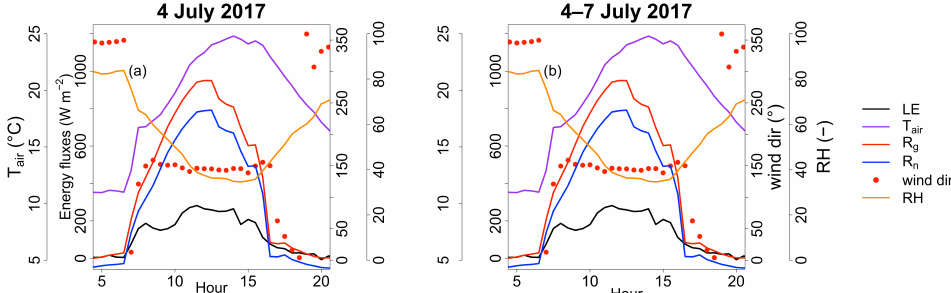
Figure 4. Diurnal cycles at half hourly temporal resolution for latent heat flux ( LE ), global radi- ation ( R g ), net radiation ( R n ), air temperature ( T air ), wind direction and relative humidity (RH). ( a ) 4 July 2017. ( b ) Mean diurnal cycles of the same variables, for the period 4–7 July 2017. The morn- ing inflexion is visible in all the panels.